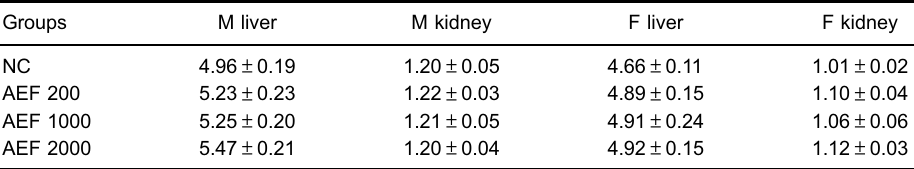
Table 1. Effect of aqueous extracts of Cnidoscolus quercifolius on relative weight of liver and kidneys of male and female mice.